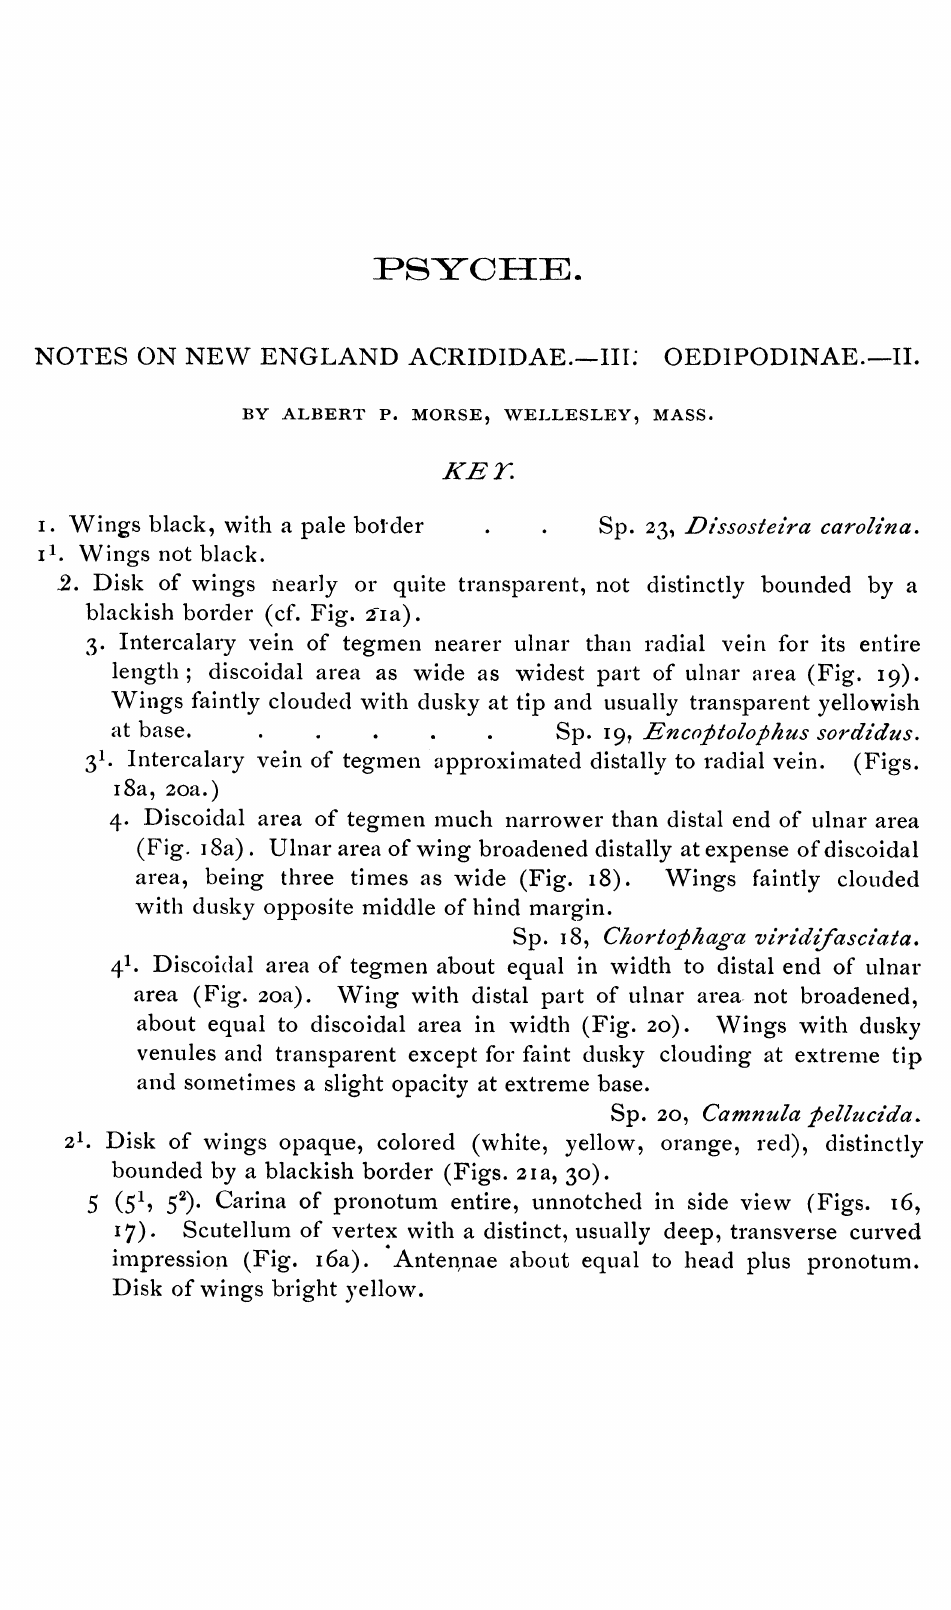
Wings faintly clouded